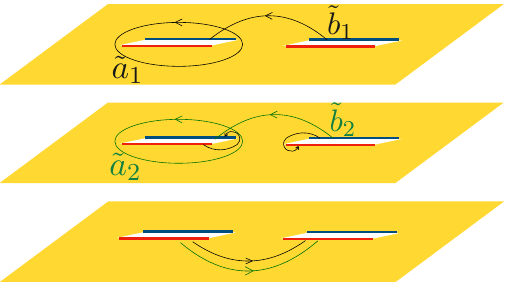
Figure 6 . Auxiliary homology basis of the surface Σ n ( x ) for n = 3